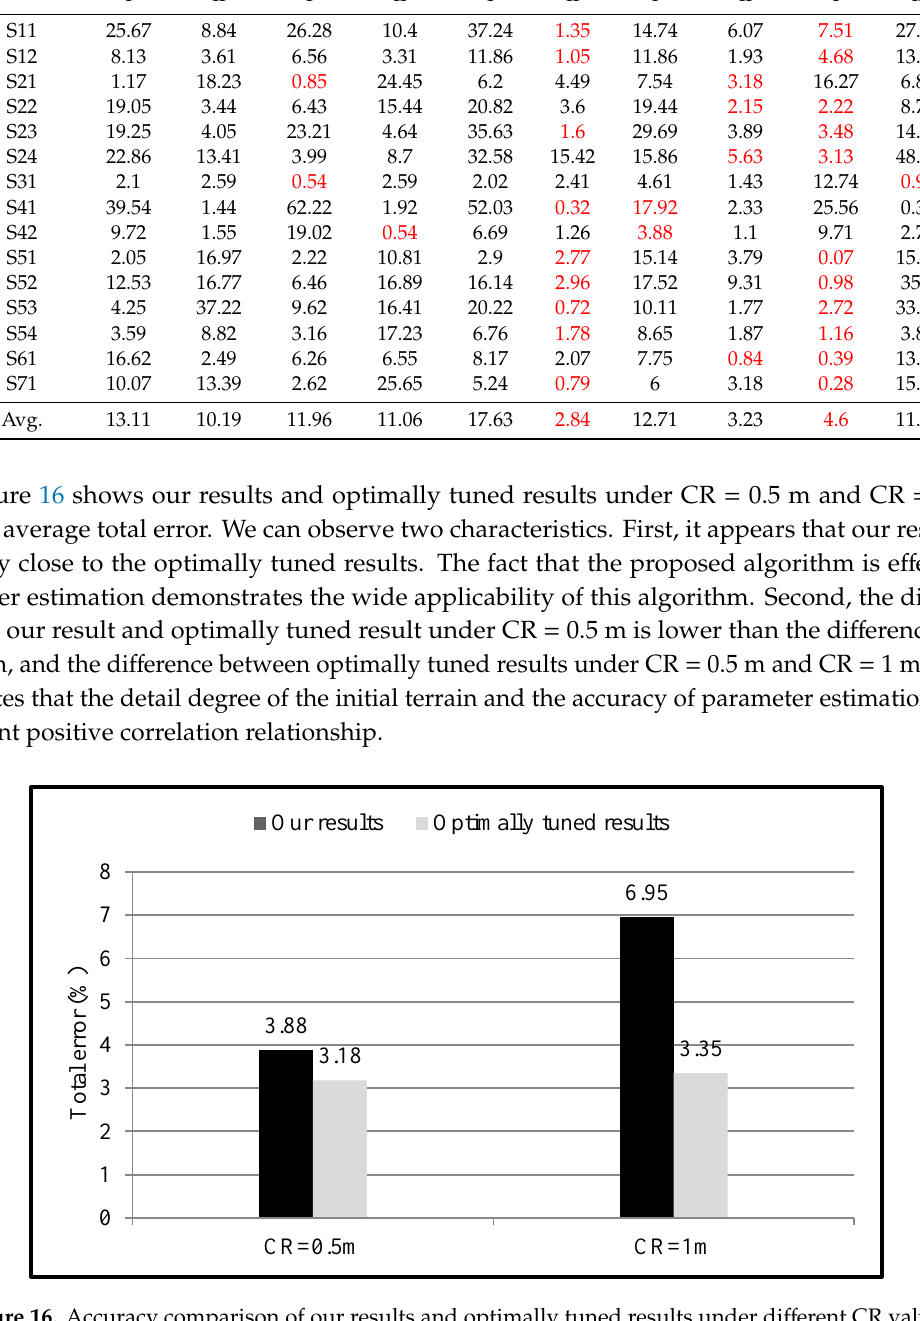
Table 3b. Performance comparison between the proposed algorithm and the publicized improved PTDF algorithms in terms of the type I and II errors (%). The best results across all the algorithms are marked in red.